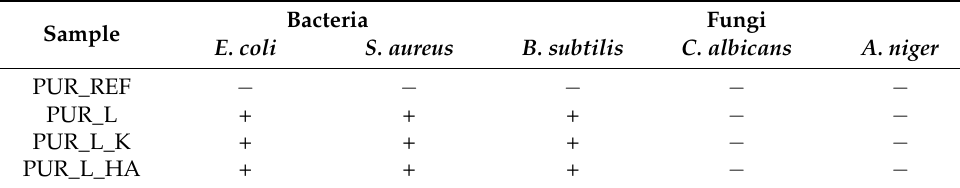
Table 3. Antibacterial properties of PUR composites against selected bacteria and fungi.